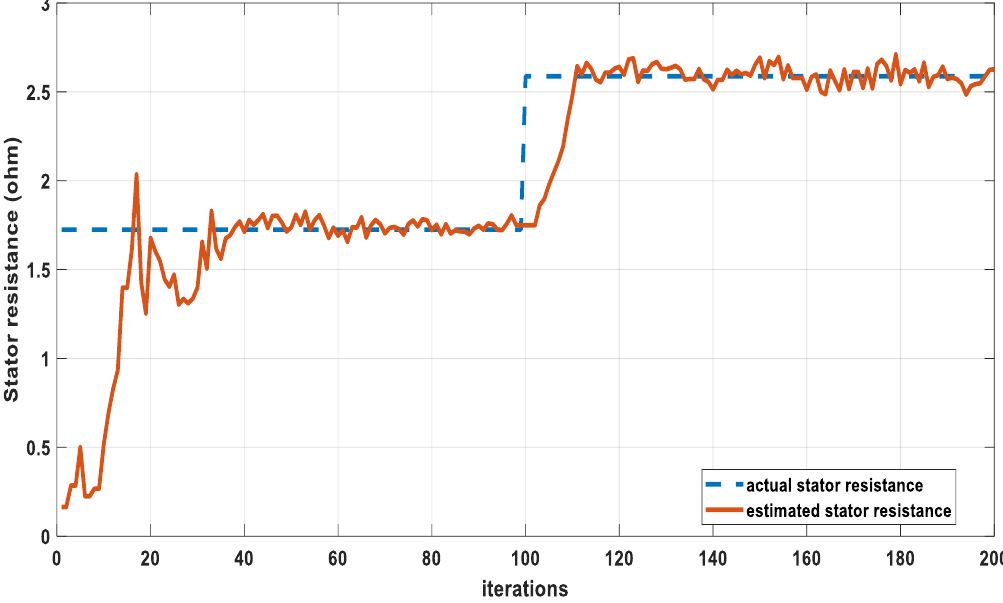
Figure 5. Stator resistance versus iteration numbers.